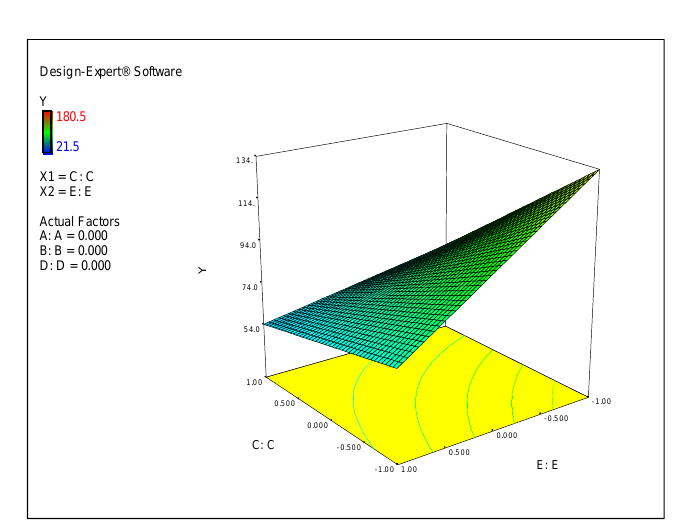
Figure 1 – 3D graph of the output Y and the contour graphs of Y for model (Myers, Montgomery and Anderson-Cook, 2009)